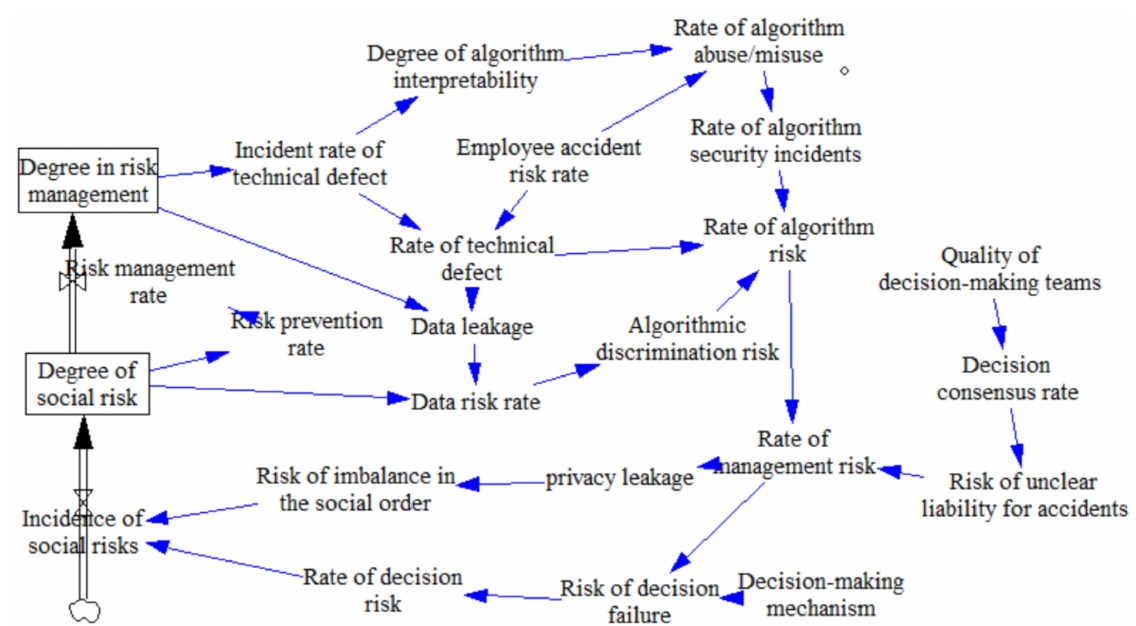
Figure 8. Risk management system flow